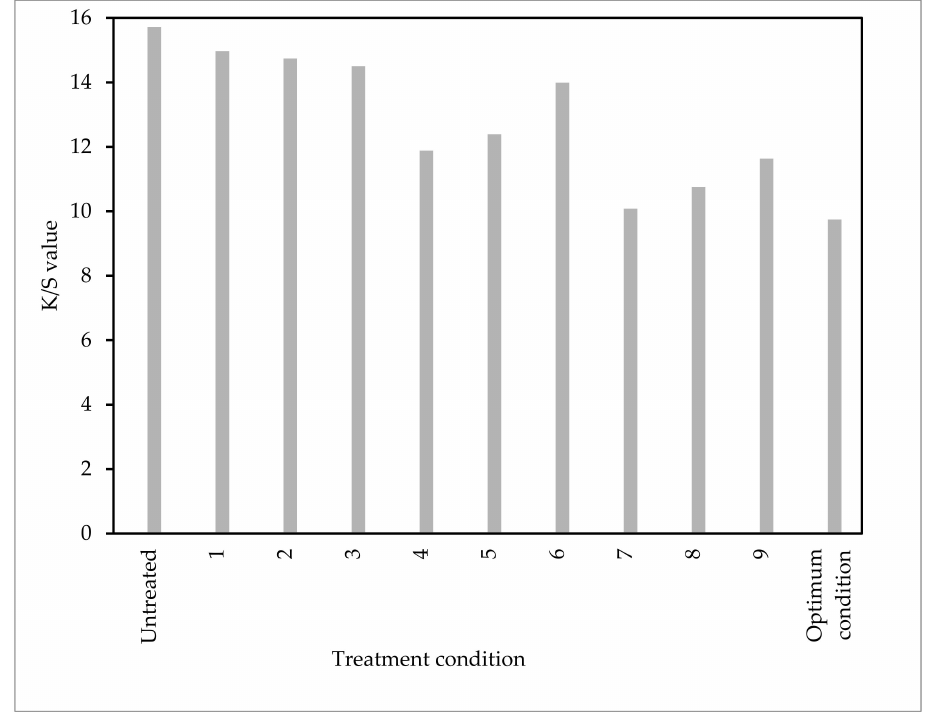
Figure 5. Verification of optimum treatment conditions for plasma-induced ozone colour-fading treatment of the sulphur-dyed knitted cotton